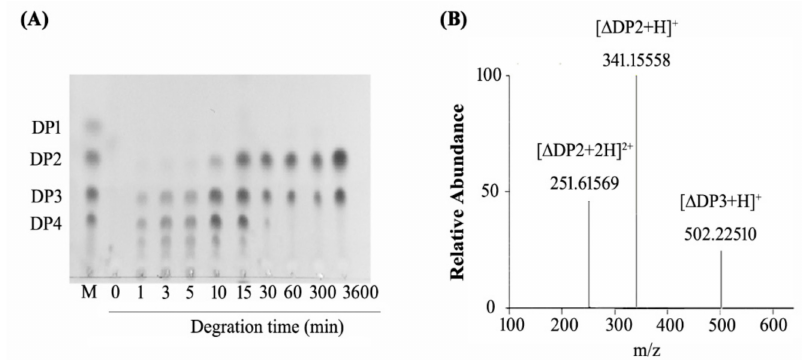
Figure 6. TLC and ESI-MS analysis of enzymatic hydrolytic products. ( A ) TLC analysis of productions after di ff erent reaction times. Lane M: standard chitooligomers (DP = 1–4). ( B ) ESI-MS analysis. (Disaccharindes: 251.61569 m / z , [ ∆ DP2 + 2H] 2 + ; 341.15558 m / z , [ ∆ DP2 + H] + . Trisaccharides: 502.22510 m / z , [ ∆ DP3 + H] +